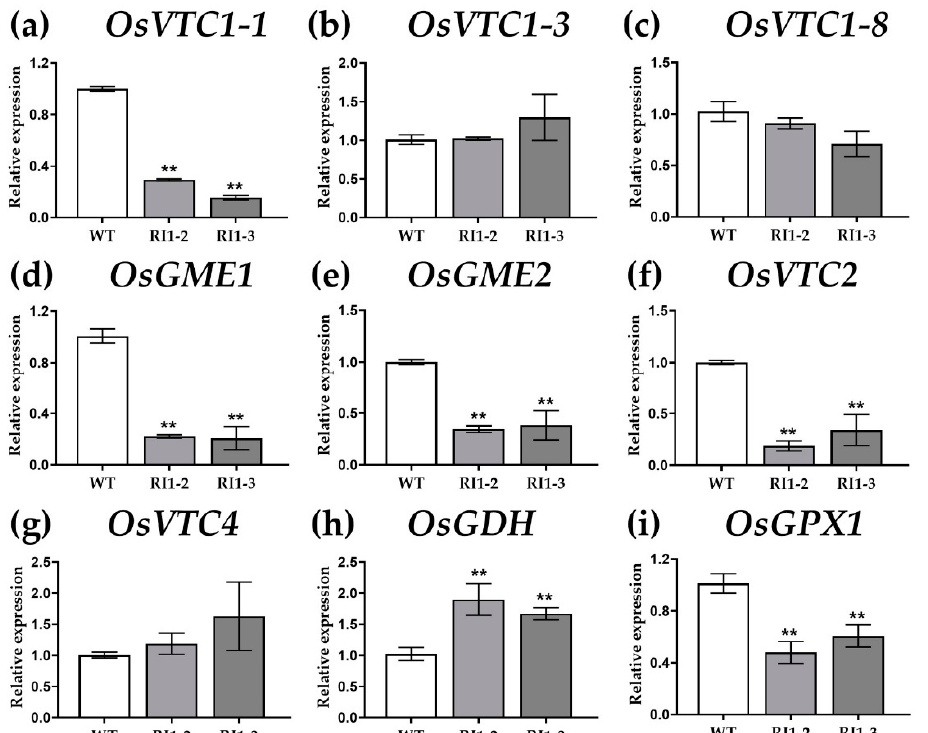
Figure 1. qPCR analysis of genes related in AsA biosynthesis pathway and antioxidant enzyme are shown as follows: ( a ) OsVTC1-1 ; ( b ) OsVTC1-3 ; ( c ) OsVTC1-8 ; ( d ) OsGME1 ; ( e ) OsGME2 ; ( f ) OsVTC2 ; ( g ) OsVTC4 ; ( h ) OsGDH ; ( i ) OsGPX1 genes. Bars represent the means and standard errors of two biological replicates (three technical replicates per biological replicate). Asterisk indicates statistically significant differences from Zhonghua17 (wild type) analyzed using Student’s t -test (** p < 0.01).